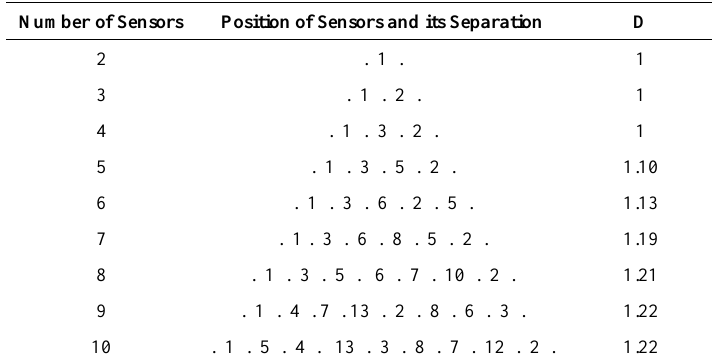
Table 2. Non-redundant arrays and representative sets of sensors.